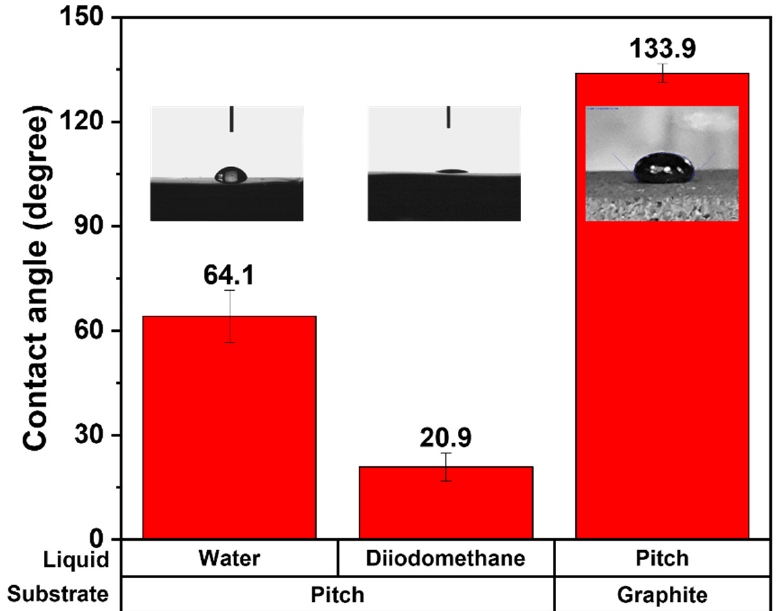
Figure 3. Contact angle measurement results for calculating minimum impregnatable pore sizes under various impregnation pressures.